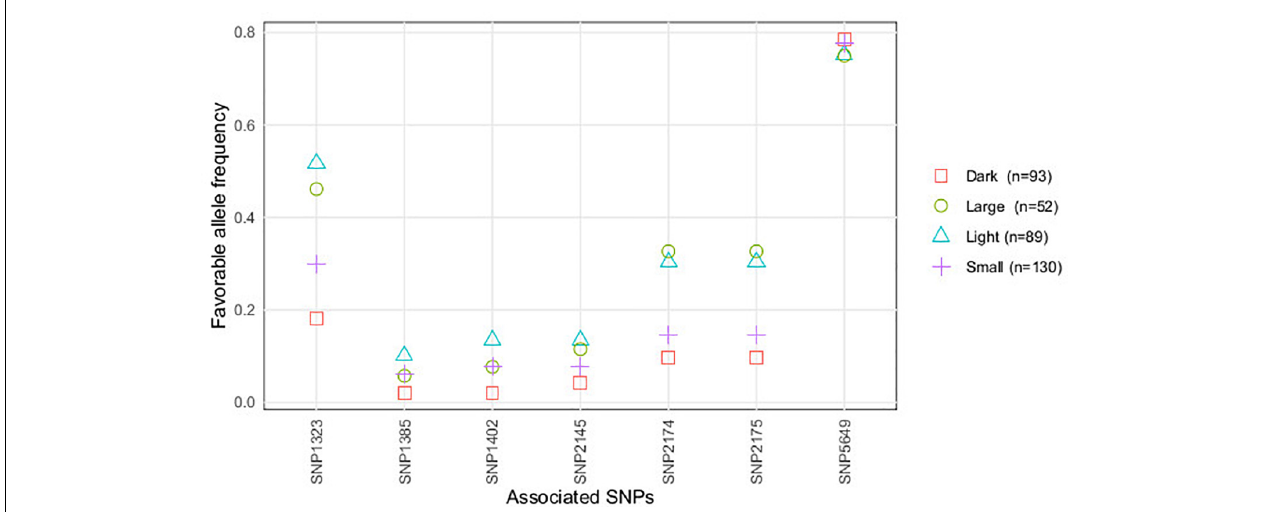
FIGURE 4 | Favorable allele’s frequency (conferring resistance) of the SNPs associated with U. pisi DS, based on the grass pea accessions classified by geographical